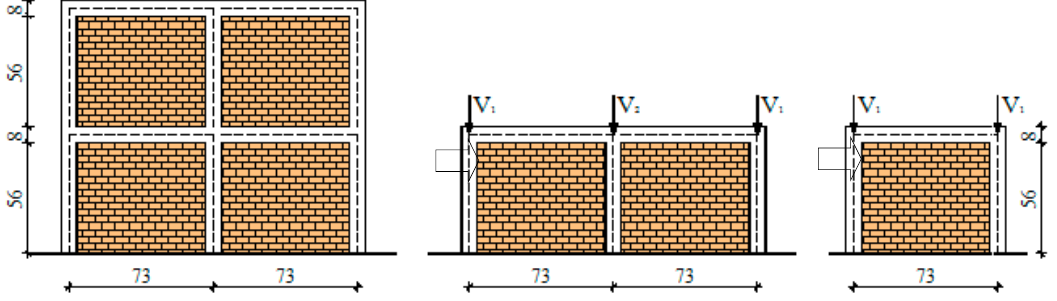
Figure 12. Approximation model for multi-storey multi-bay infilled frame IFS.